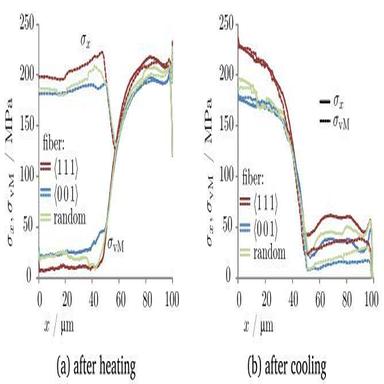
Distribution of the stress in x-direction and the VON MISES stress within the conductor paths after 50 load cycles averaged along the positions depicted in